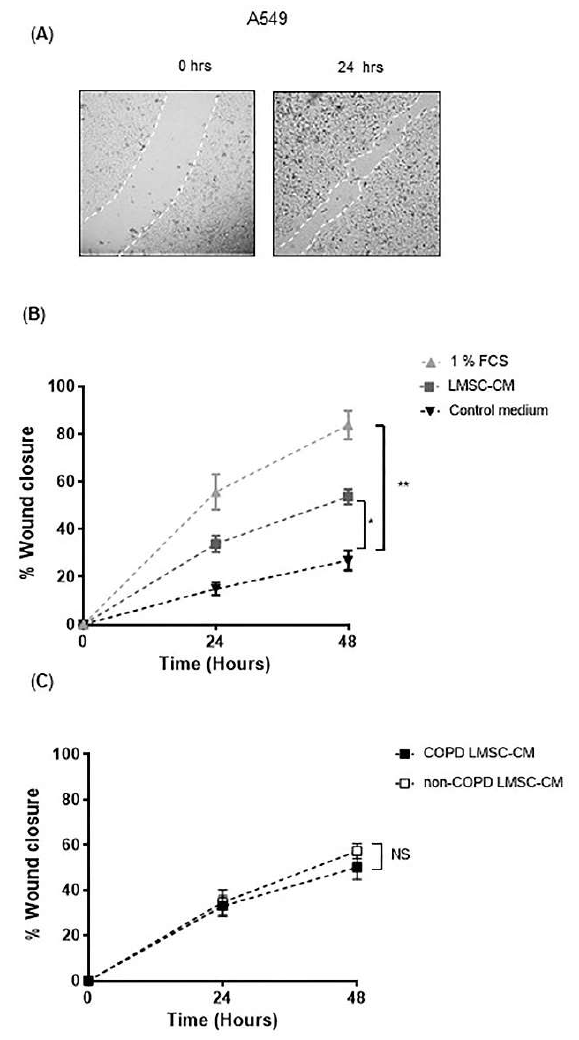
Figure 3. Conditioned medium from lung-resident MSCs (LMSCs) improves recovery wound repair of A549 cells after scratch wounding. A549 cells were seeded in duplicates in ECIS arrays and grown to confluence for 48 h. Medium was refreshed and replaced by control medium, medium containing 1% FCS (positive control) or conditioned medium (CM) of LMSCs from 6 non-COPD control and 6 COPD donors. After 24 h, cells were wounded by scratching. Relative wound closure was assessed by measuring the average length from one side of the scratch to the other at 0, 24 and 48 hrs derived from 3 measurements using ImageJ. ( A ) A representative light microscopy image of scratching of the A549 monolayer and its recovery. ( B ) Percentage wound closure in A549 cells treated with or without 1% FCS (positive control) or LMSC-CM from non-COPD control and COPD donors ( n = 12, non-COPD and COPD LMSC-CM combined). Mean ± SEM levels are shown. ( C ) Percentage wound closure in A549 cells treated with LMSC-CM from non-COPD control or COPD donors ( n = 6/group). Mean ± SEM levels are shown. To test for differences between control medium and LMSC-condition medium, 2-way ANOVA was used. * = p < 0.05 and ** = p < 0.01 between the indicated